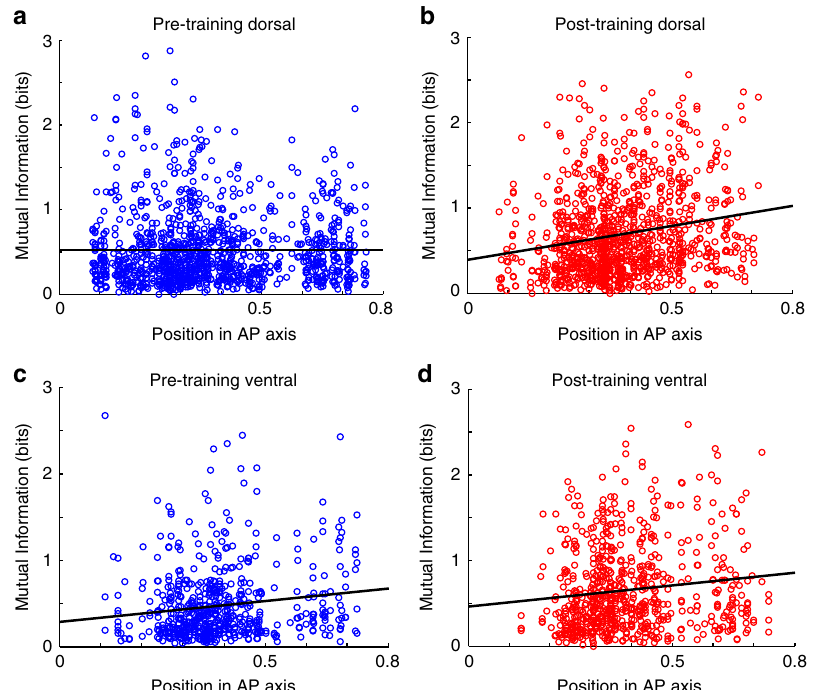
Fig. 5 Mutual information analysis. a Mutual Information values based on spike counts in the 1.5 s of the delay period are plotted along the Anterior- Posterior axis of the dorsal prefrontal cortex before and after training. Each point represents the Mutual Information value of one neuron, prior to training. Line represents linear regression. b Mutual Information values in the ventral prefrontal cortex. c – d Mutual information values after training. Total sample size, n = 3508 neurons